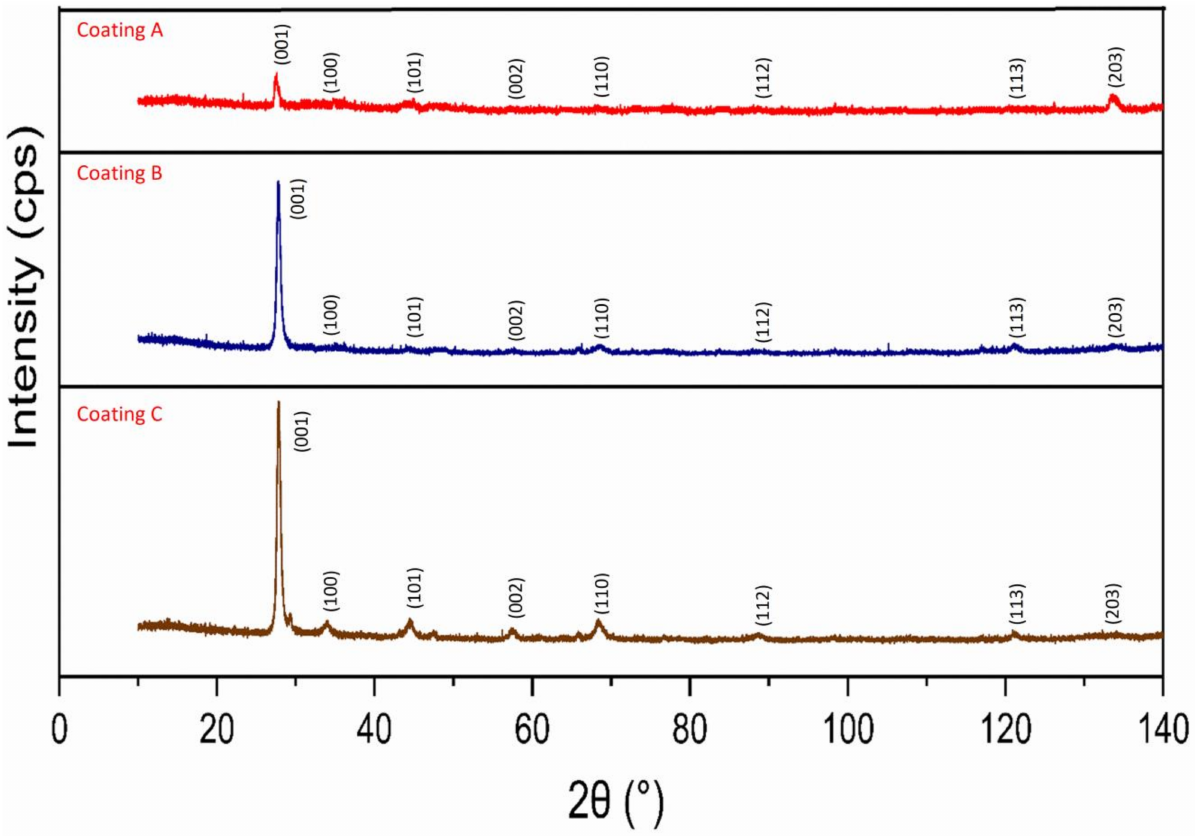
Figure 6. X-ray diffraction patterns of the three TiB 2